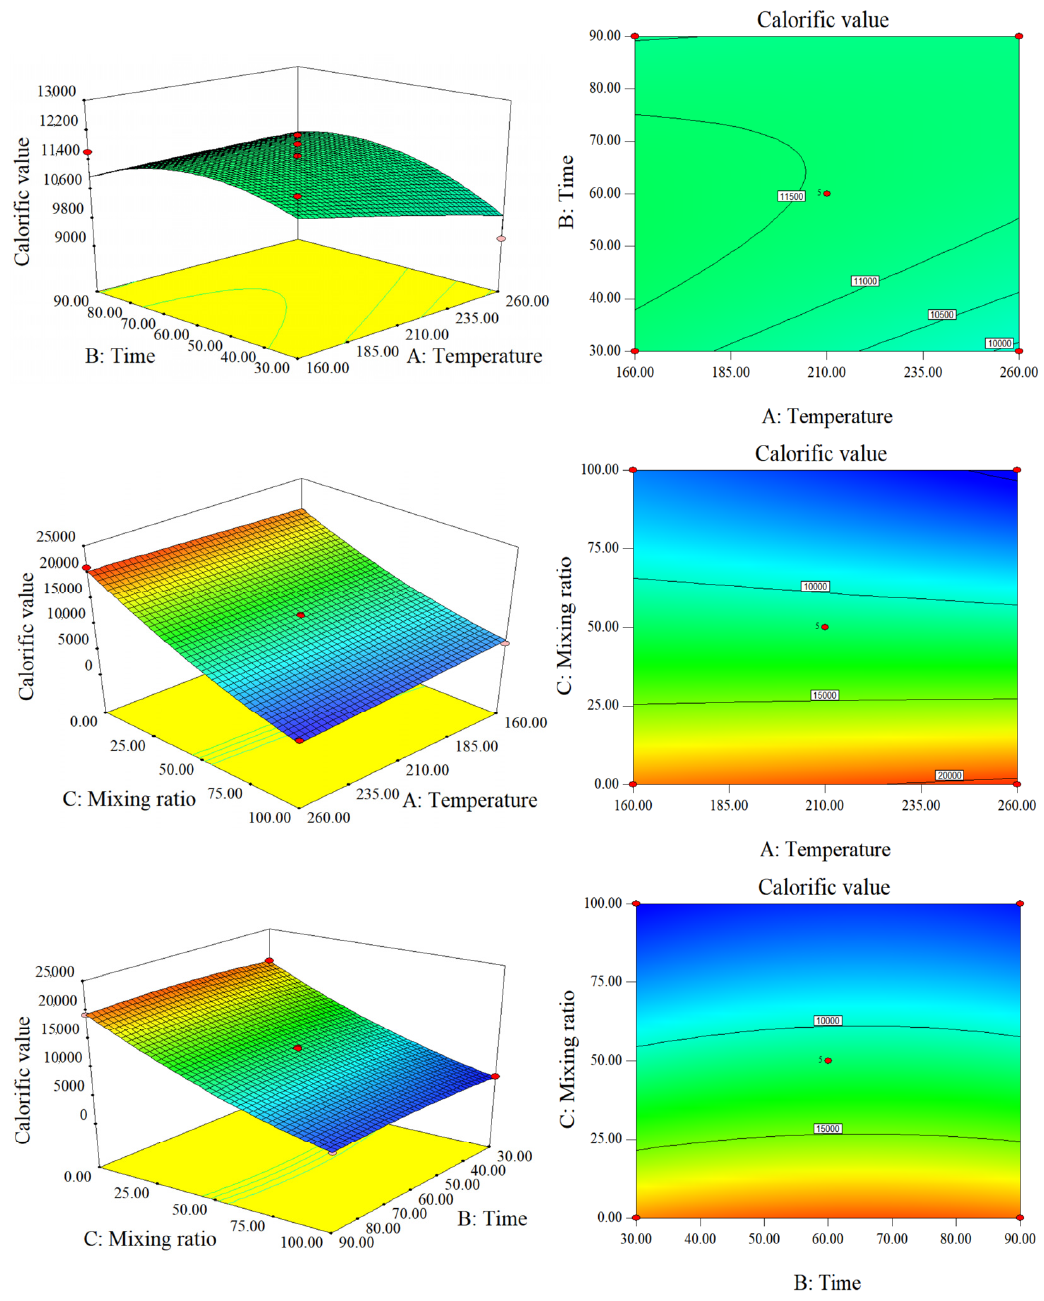
Figure 2. Response surface plots and contour plots of HHV.